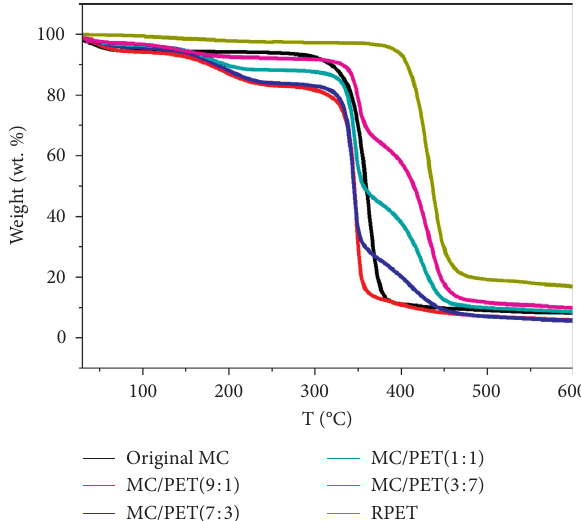
Figure 4: TGA curves of original MC, RPET, and MC/PET films.